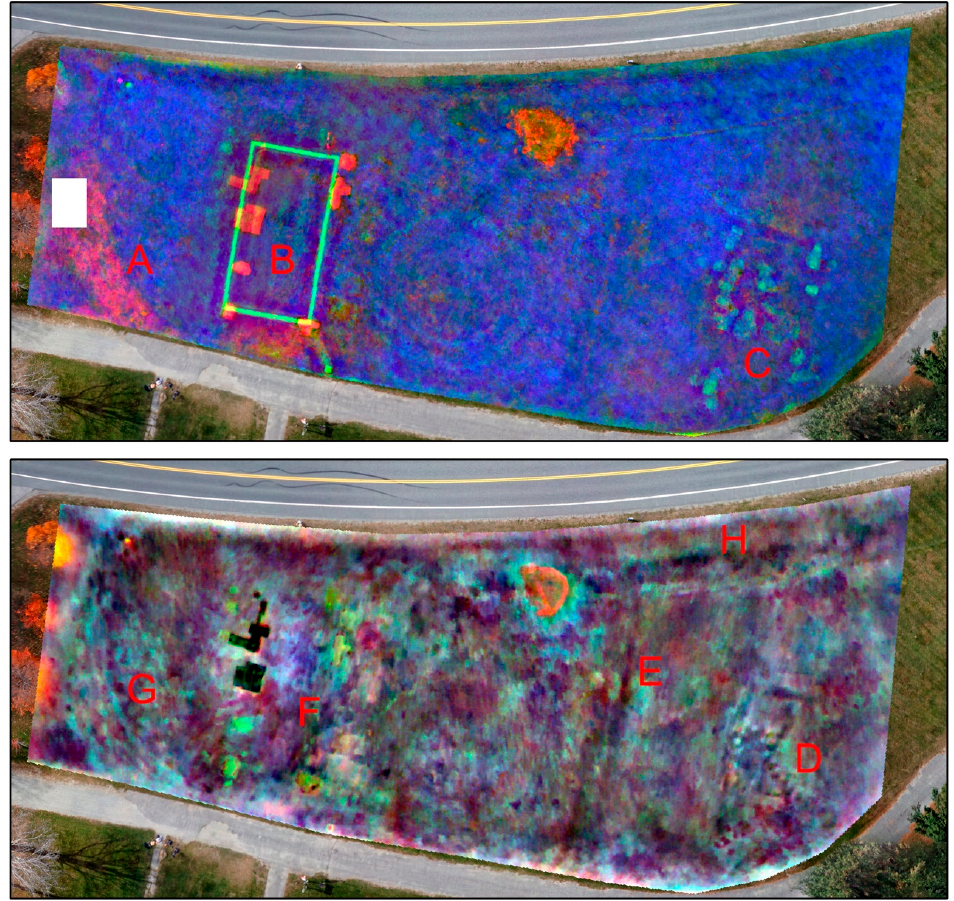
Figure 7. ( top ) False color image from 3 bands of a multi-band raster consisting of 16 layers of thermal and multi-spectral data; ( bottom ) False color image of the first three principal components from a Principal Component Analysis (PCA) of the multi-band raster above.